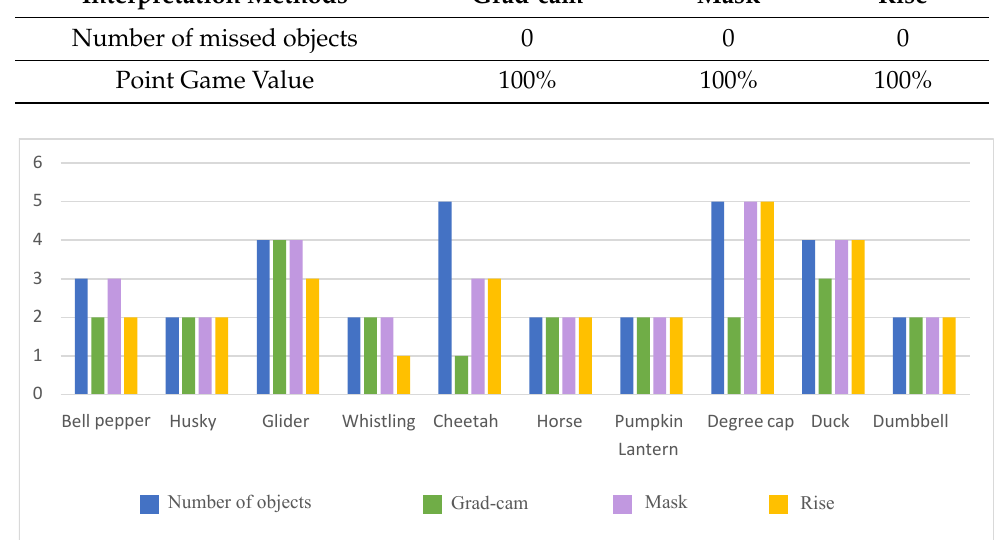
Figure 19. The statistical result of the number of objects hit by different interpretation algorithms. Each interpretation method is tested with 10 images from DataM and 35